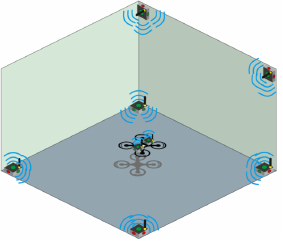
Figure 2. Concept of the ultrasound mobile beacon